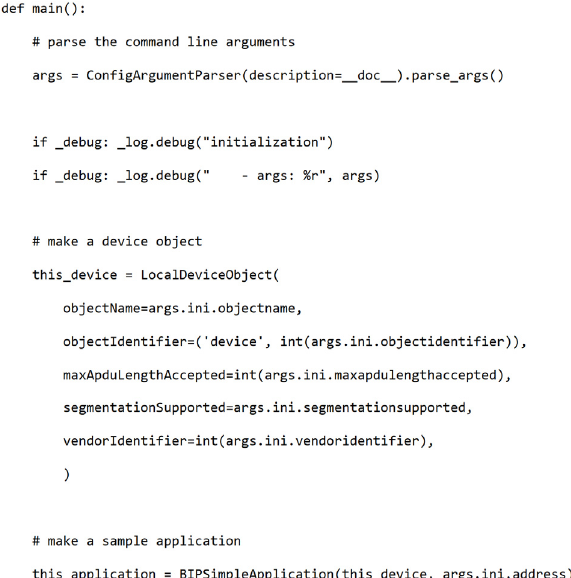
Figure 11. Create BACnet device object using Python.